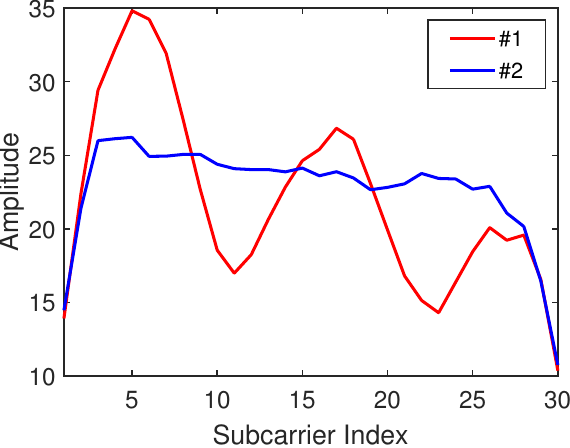
Figure 4. Channel state information (CSI) amplitude waveform of adjacent